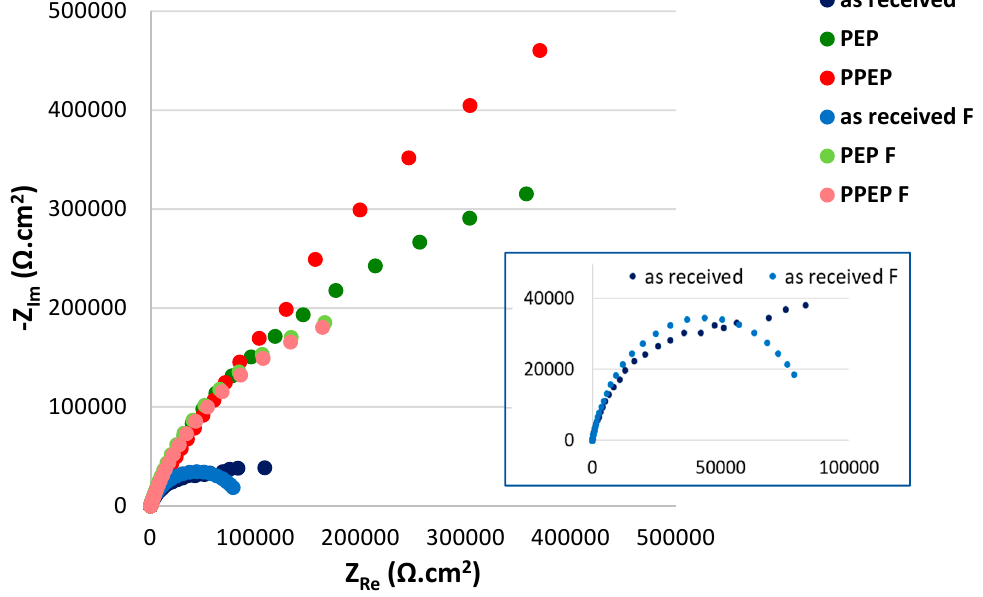
Figure 5. Nyquist plots for tested surface conditions (fitted curves are “F” marked). Table 5. Values of EIS parameters.